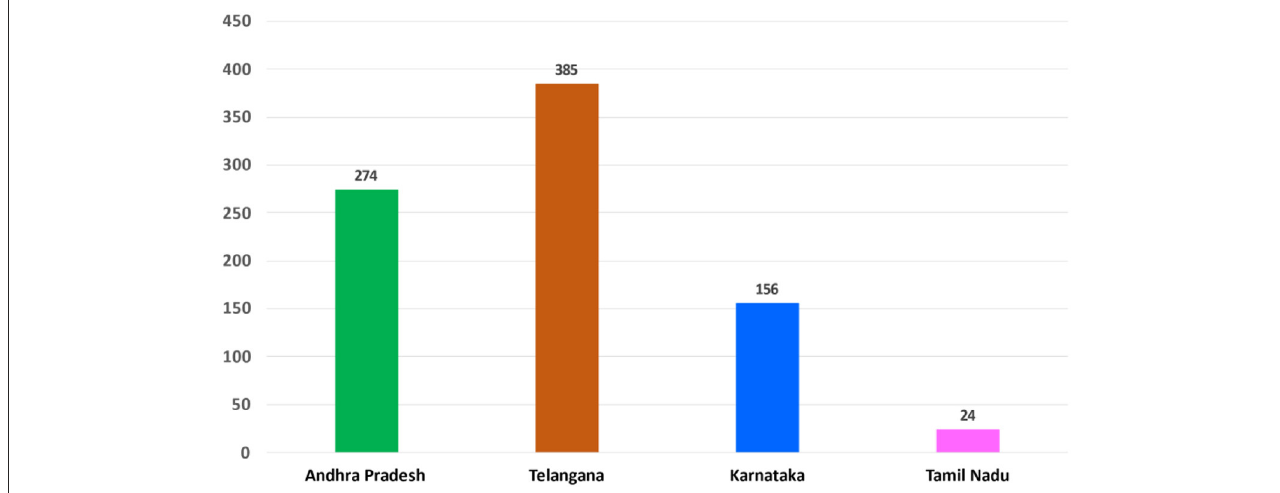
FIGURE1 Number of Mandals declared drought in the southern states of India, 2019 (Source: Statistical Abstracts of selected States, 2020).